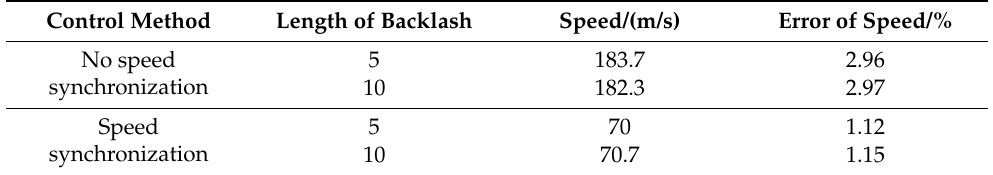
Table 4. Velocity error of different